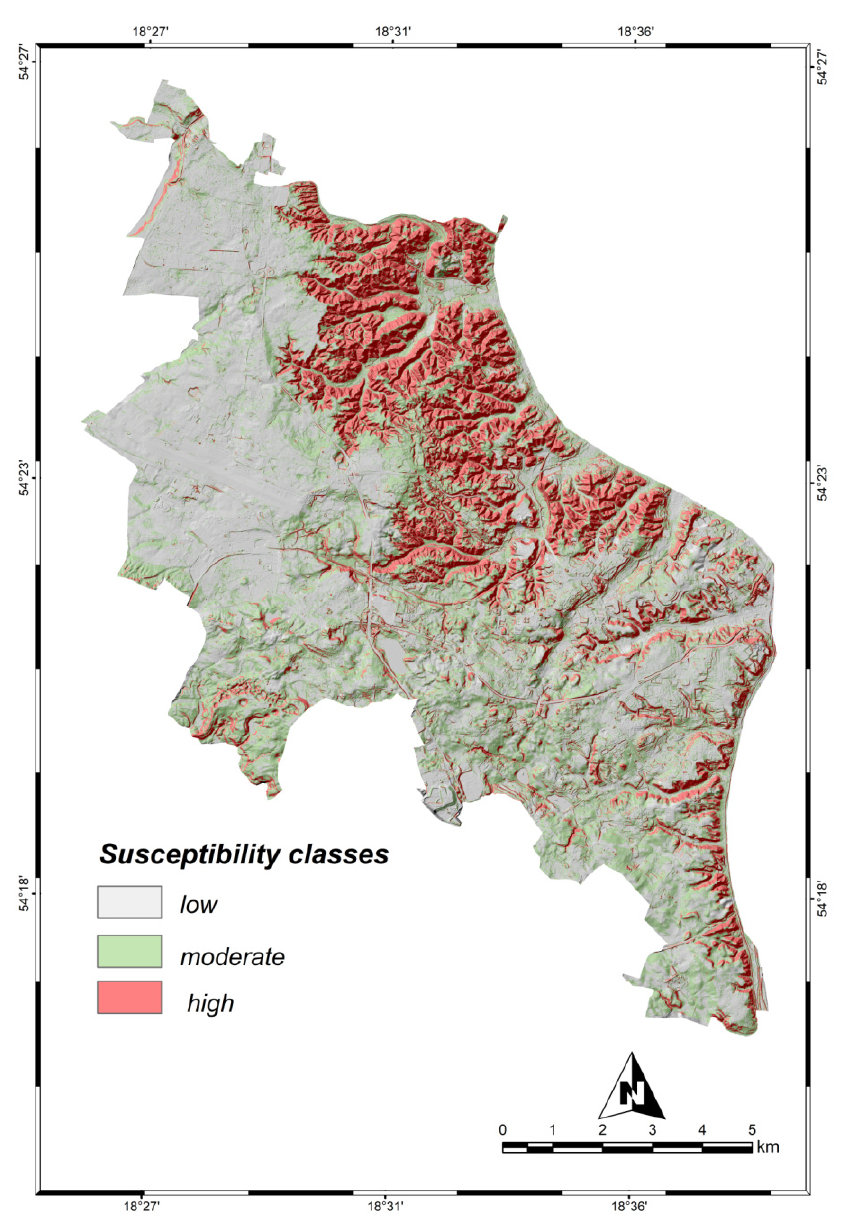
Figure 5. Landslide susceptibility map of Gda ń sk developed using statistical landslide index (SLI).